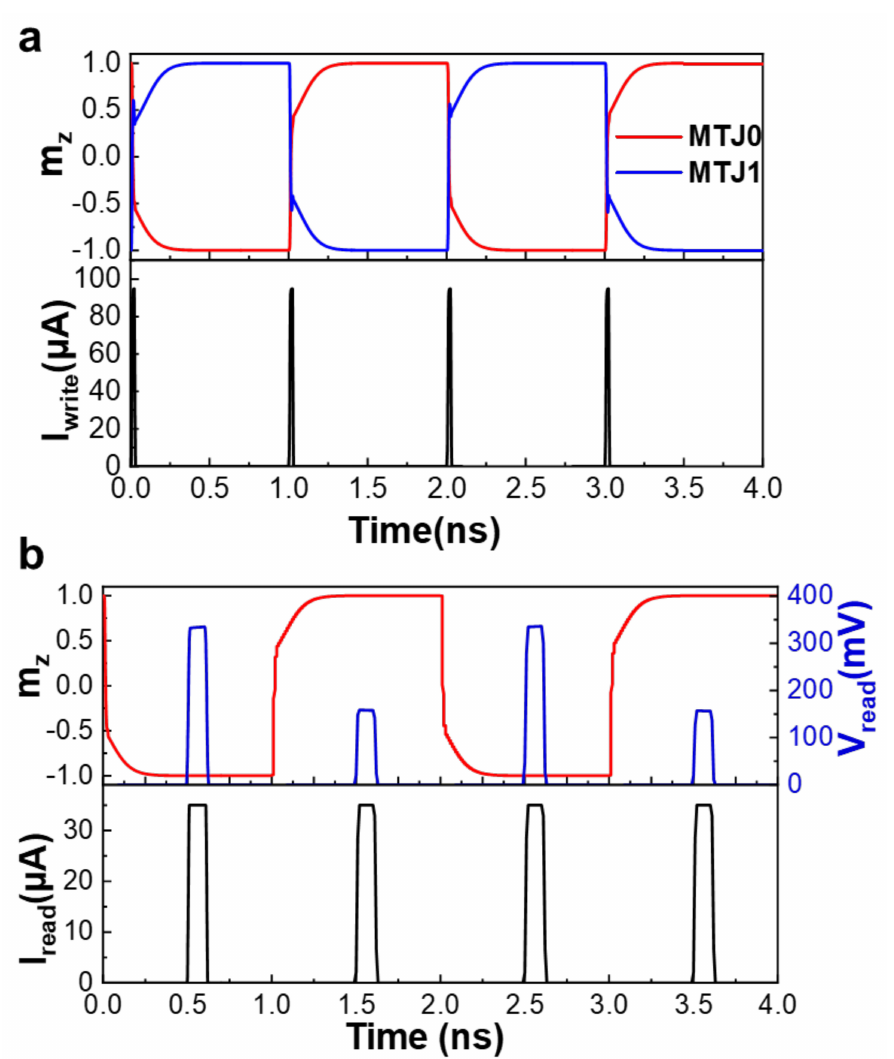
Figure 5. Writing and reading process for 3T2M storage cell. ( a ) The switching of magnetization of MTJ0 and MTJ1 with successive I write applied to the writing path. ( b ) The read pulse I read is applied to the MTJ after the writing operation, and the read voltage and V read is generated in MTJ0 with difference m z